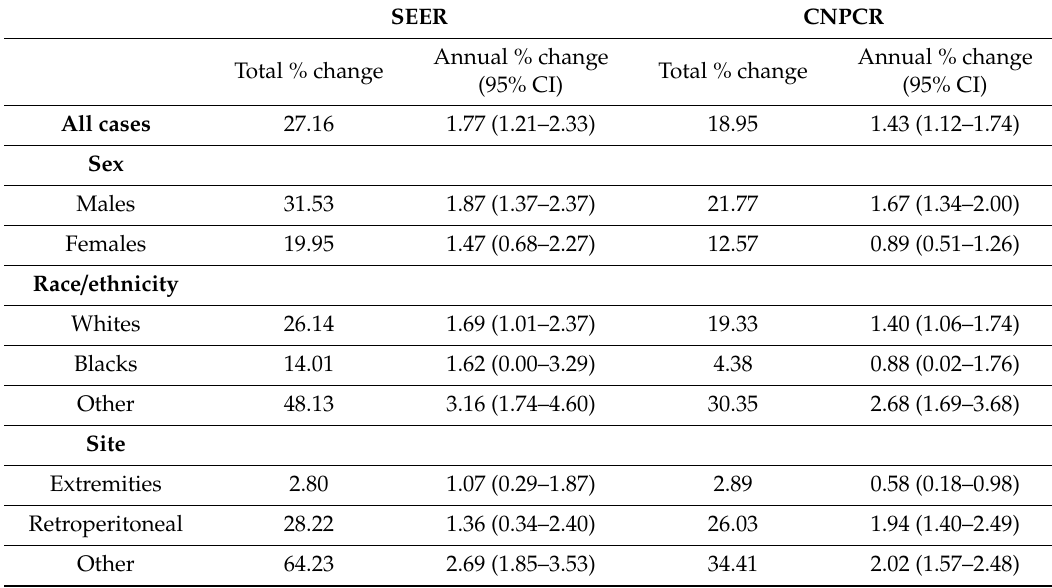
Table 3. Time trends in liposarcoma, 2001–2016.